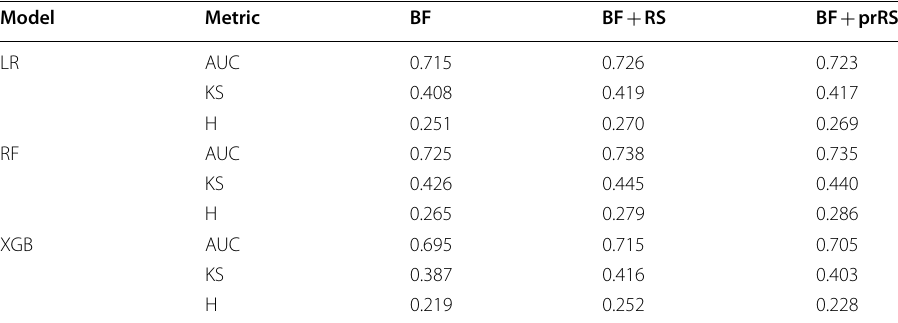
Table 6 Discrimination performance of different feature